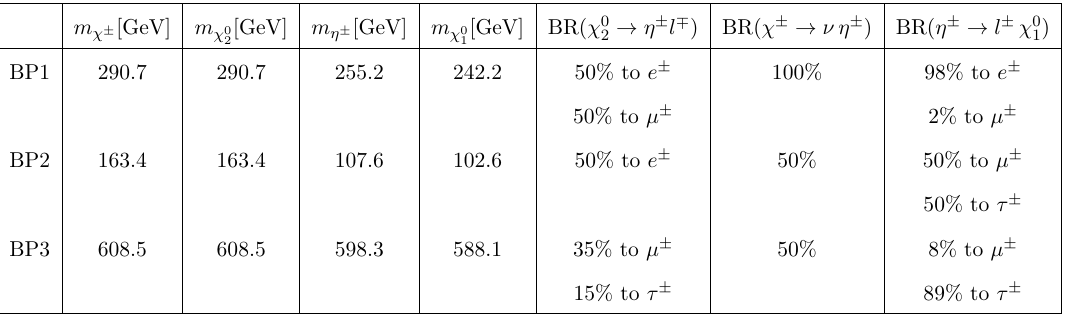
Table 3 . Benchmark points to look at for collider